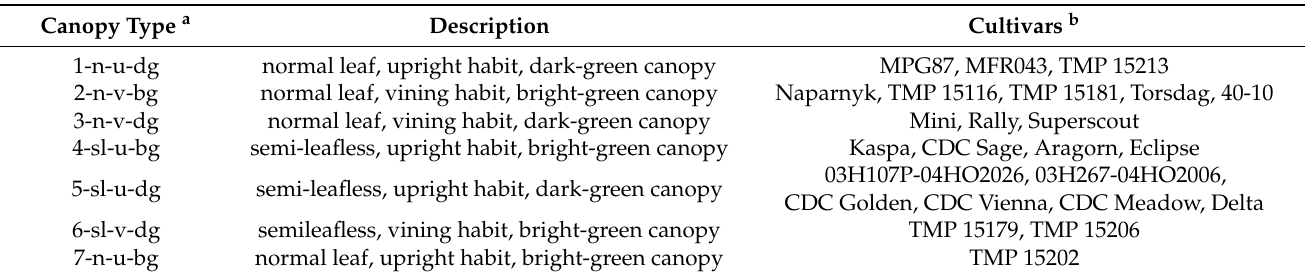
Table 1. Canopy type, description, and name of 24 pea cultivars evaluated for heat resistance traits at Rosthern and Saskatoon, Canada, in